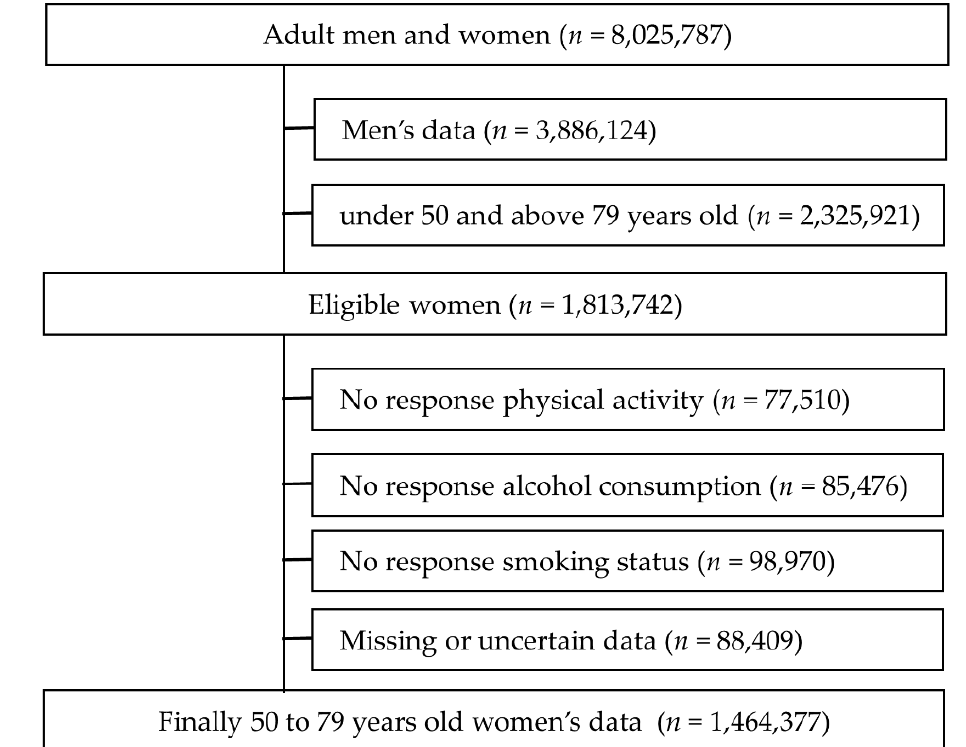
Figure 1. Participant’s exclusion and inclusion process.